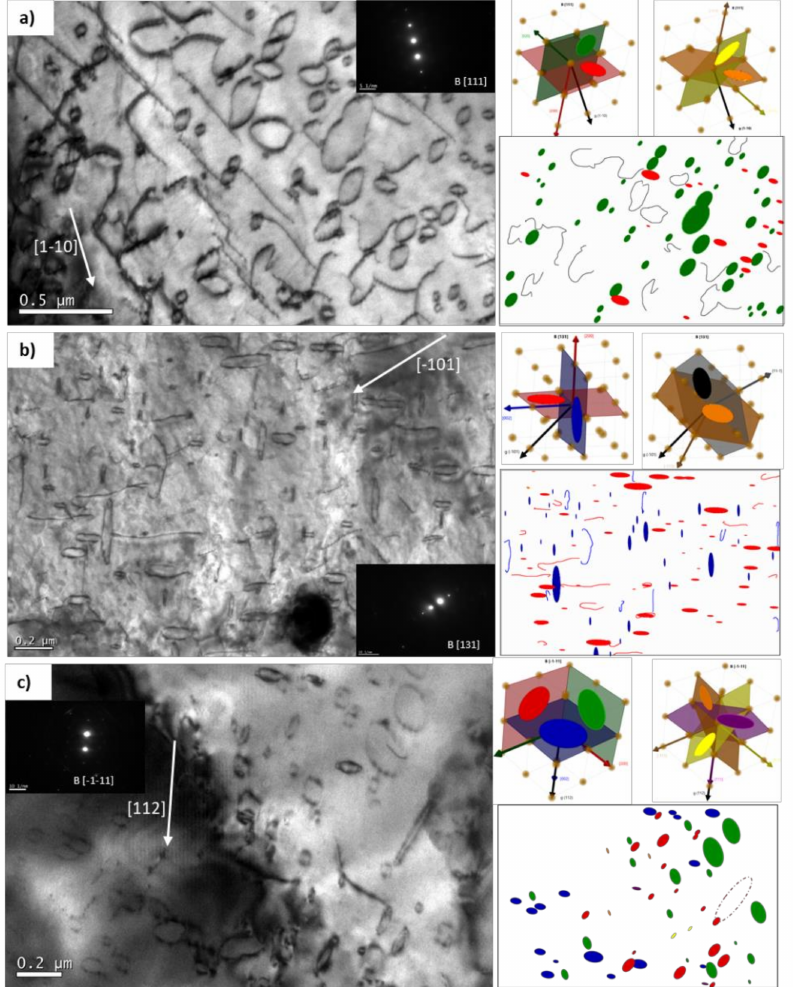
Figure 21. TEM micrographs of pure EFDA iron irradiated with Fe ions at 20 MeV at 300 ◦ C up to 8.5 × 10 15 ions/cm 2 under ( a ) [111] with g [110]; ( b ) [131] with g [101]; and ( c ) [111] with g [112] showing the results for every